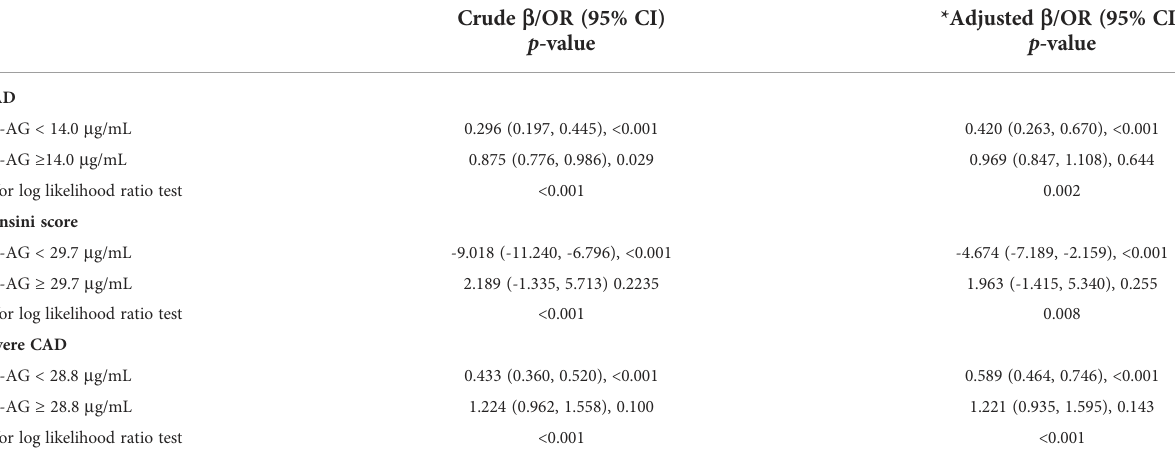
TABLE 4 Threshold effect analysis of 1,5-AG (per 1-SD increment) on coronary angiography de fi ned CAD, Gensini score and the severity of CAD.